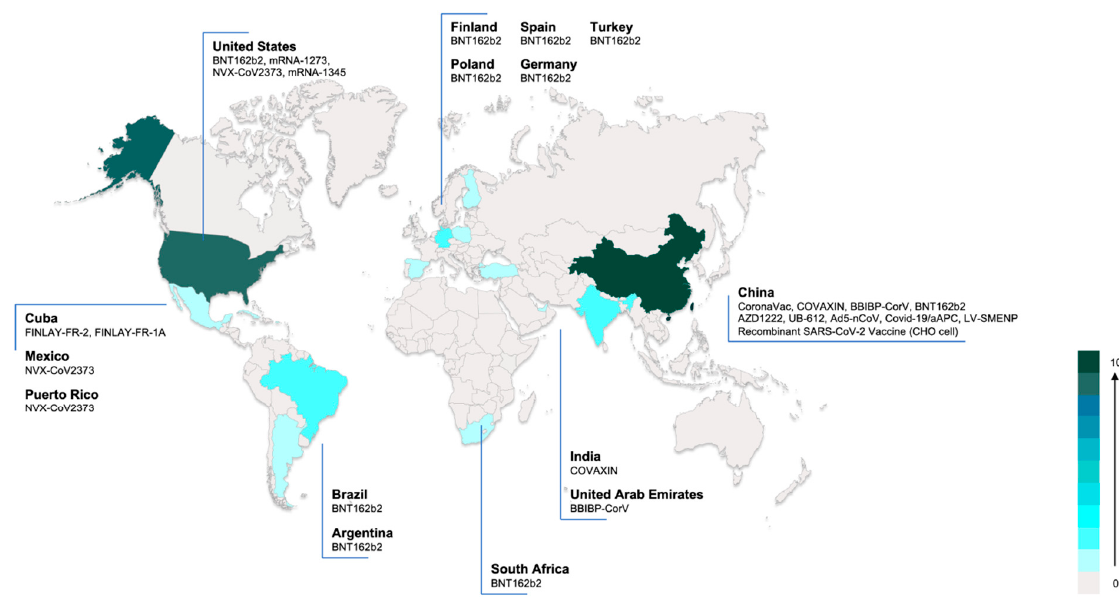
Figure 2. Ongoing interventional COVID-19 vaccine trials in children and adolescents worldwide. Color in the figure indicates the number of ongoing vaccine trials in each country.